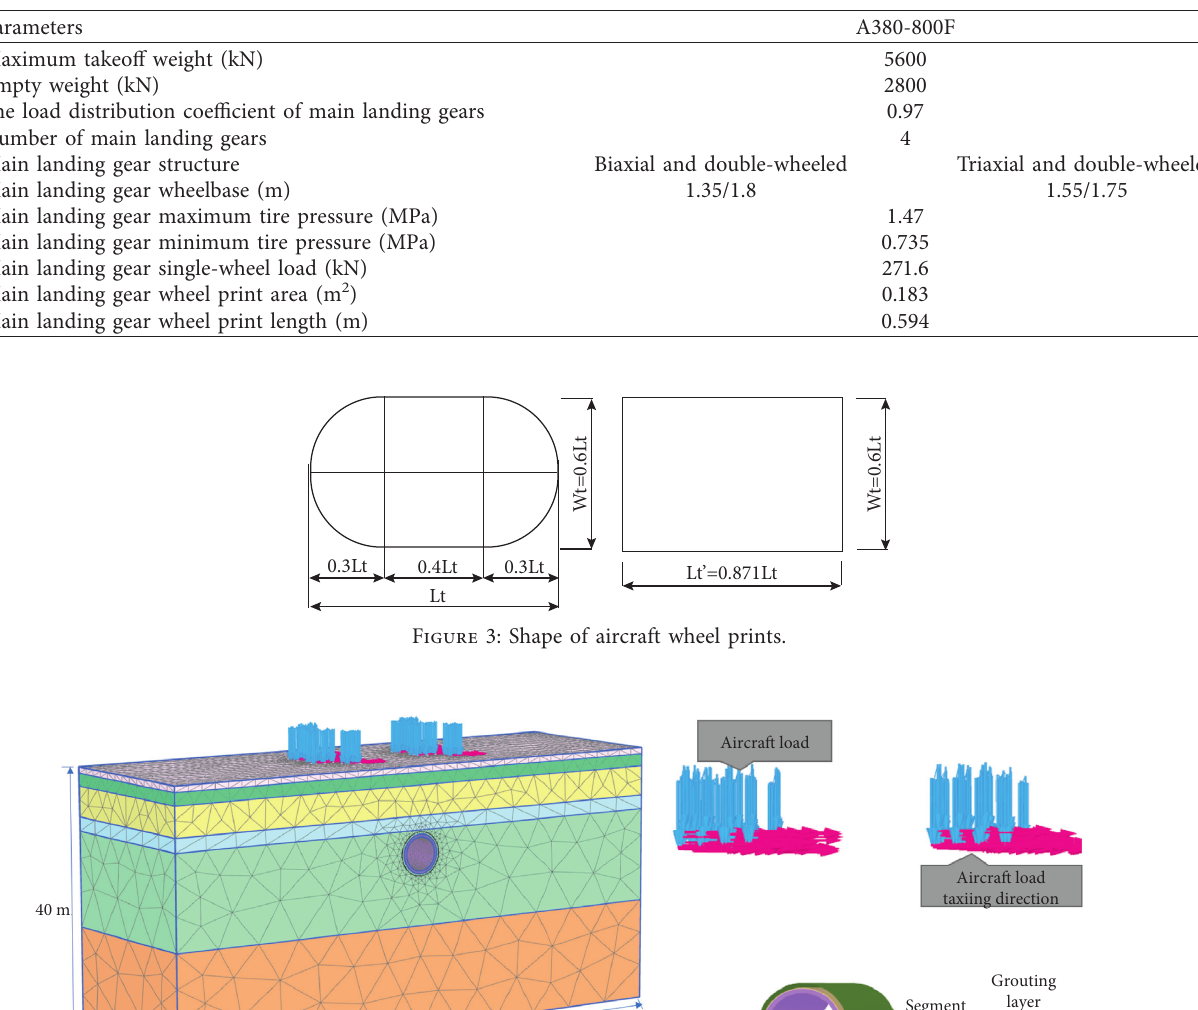
Table 1: Aircraft parameters.